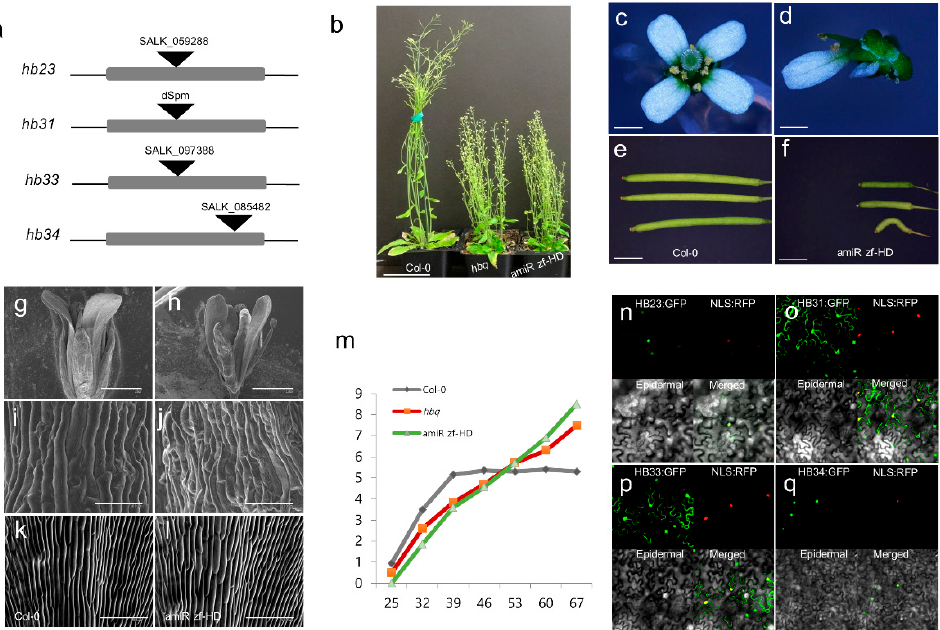
Figure 1. amiR zf-HD and hbq lines exhibit plant architecture phenotypes. ( a ) T-DNA insertion sites in HB23 , HB33, and HB34 and dSpm transposon insertion in HB31 . ( b ) From left to right: mature Col-0 (Wild Type, WT), hbq, and amiR zf-HD; scale bar: 5 cm. ( c – f ) Floral architecture in Col-0 ( c ) and amiR zf-HD ( d ); bar: 1 mm. Silique shape in Col-0 ( e ) and amiR zf-HD ( f ); bar: 1 mm. ( g – l ) Scanning electron microscope picture showing floral morphology in Col-0 and amiR zf-HD. Flower in Col-0 ( g ) and amiR zf-HD ( h ); scale bar: 1 mm. Sepal in Col-0 ( i ) and amiR zf-HD ( j ); bar: 100 µm. Proximal part of petal in Col-0 ( k ) and amiR zf-HD ( l ); bar: 100 µm. ( m ): Lateral branching number of Col-0, hbq , and amiR zf-HD, during development. X axis: days after germination. Y axis: number of branches. ( n – q ) Confocal images of localization of HB23 ( n ), HB31 ( o ), HB33 ( p ), and HB34 ( q ) in tobacco epidermal cells in the transient expression assay. GFP is green, and NLS-RFP is red.